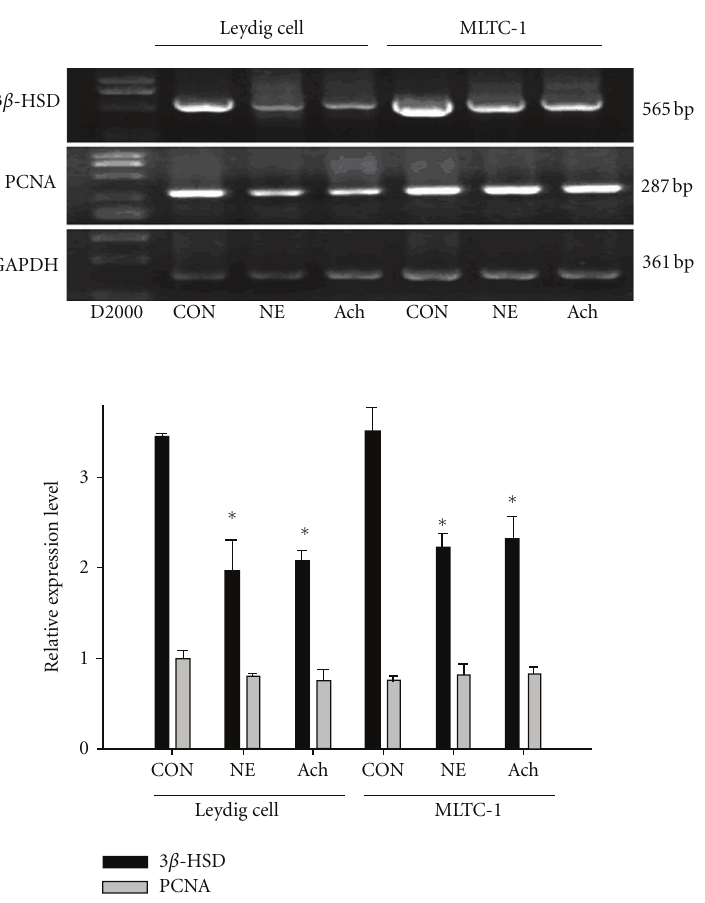
Figure 5: Expression levels of 3 β -HSD mRNA and PCNA mRNA in the cultured adult Leydig cells and MLTC-1 treated with NE, and Ach. Asterisks ( ∗ ) indicate statistical significance ( P < 0 . 05) between the CON, NE and Ach groups. CON: Control group cultured with the same dilution of NE and Ach. NE: NE group cultured in the presence of 10 μ M NE. Ach: Ach group cultured in the presence of 10 μ M Ach.